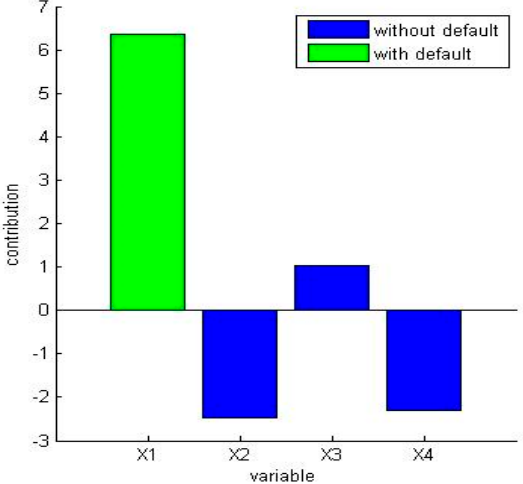
Figure 11. Fault isolation using the proposed approach.